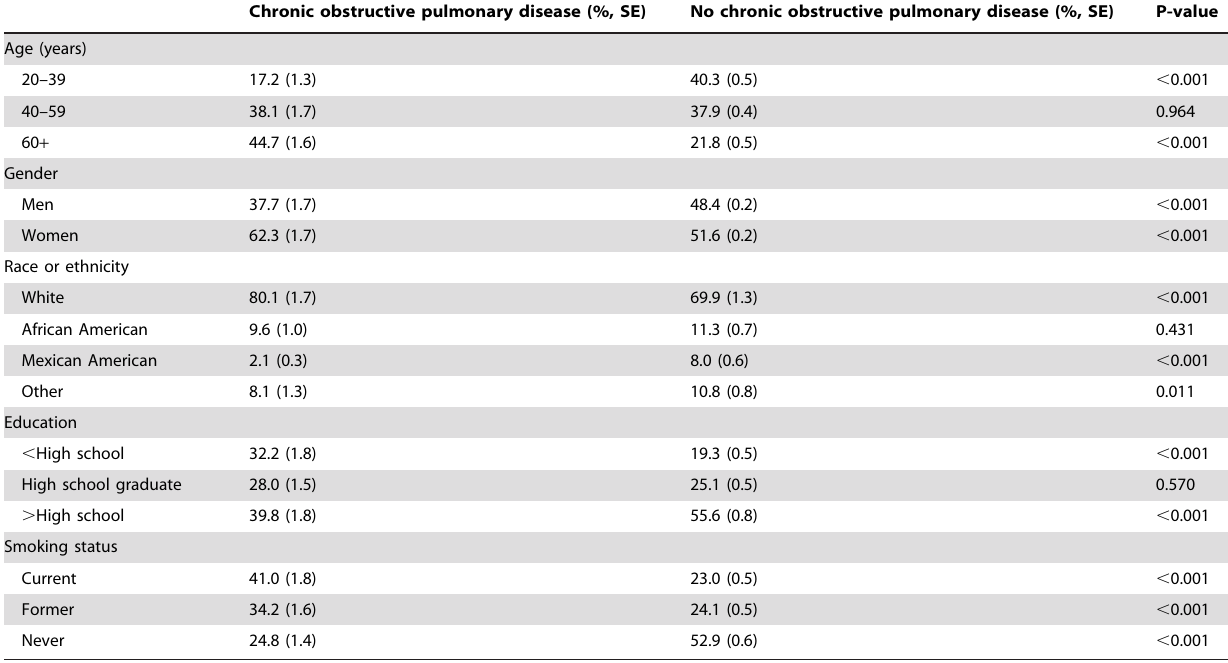
Table 2. Selected characteristics, by self-reported chronic obstructive pulmonary disease status, National Health and Nutrition Examination Survey